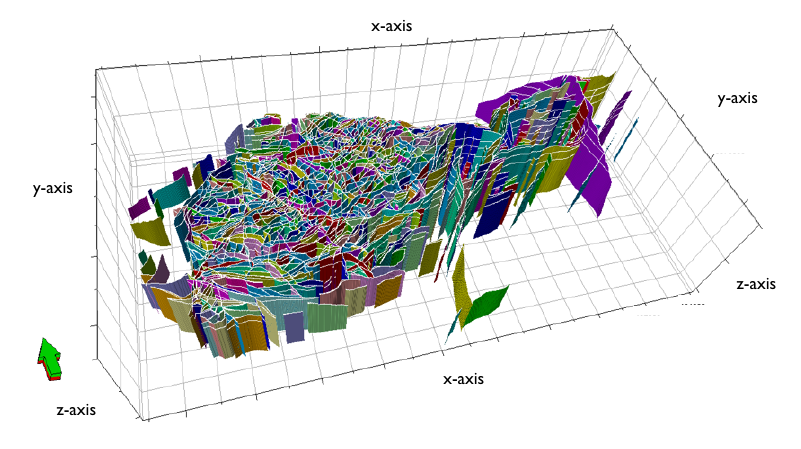
Fig. 4. Fault planes interpreted from seismic data are just one input type for a fractured basement reservoir model. This example is from the Lancaster field (see Fig. 1. for location). The grid cells are 1 km 3 . The arrow points north, and the green face points to shallower depths. Modelling the intervening reservoir matrix can be facilitated by analysing appropriate analogue outcrops. (Reproduced with permission from Belaidi et al.